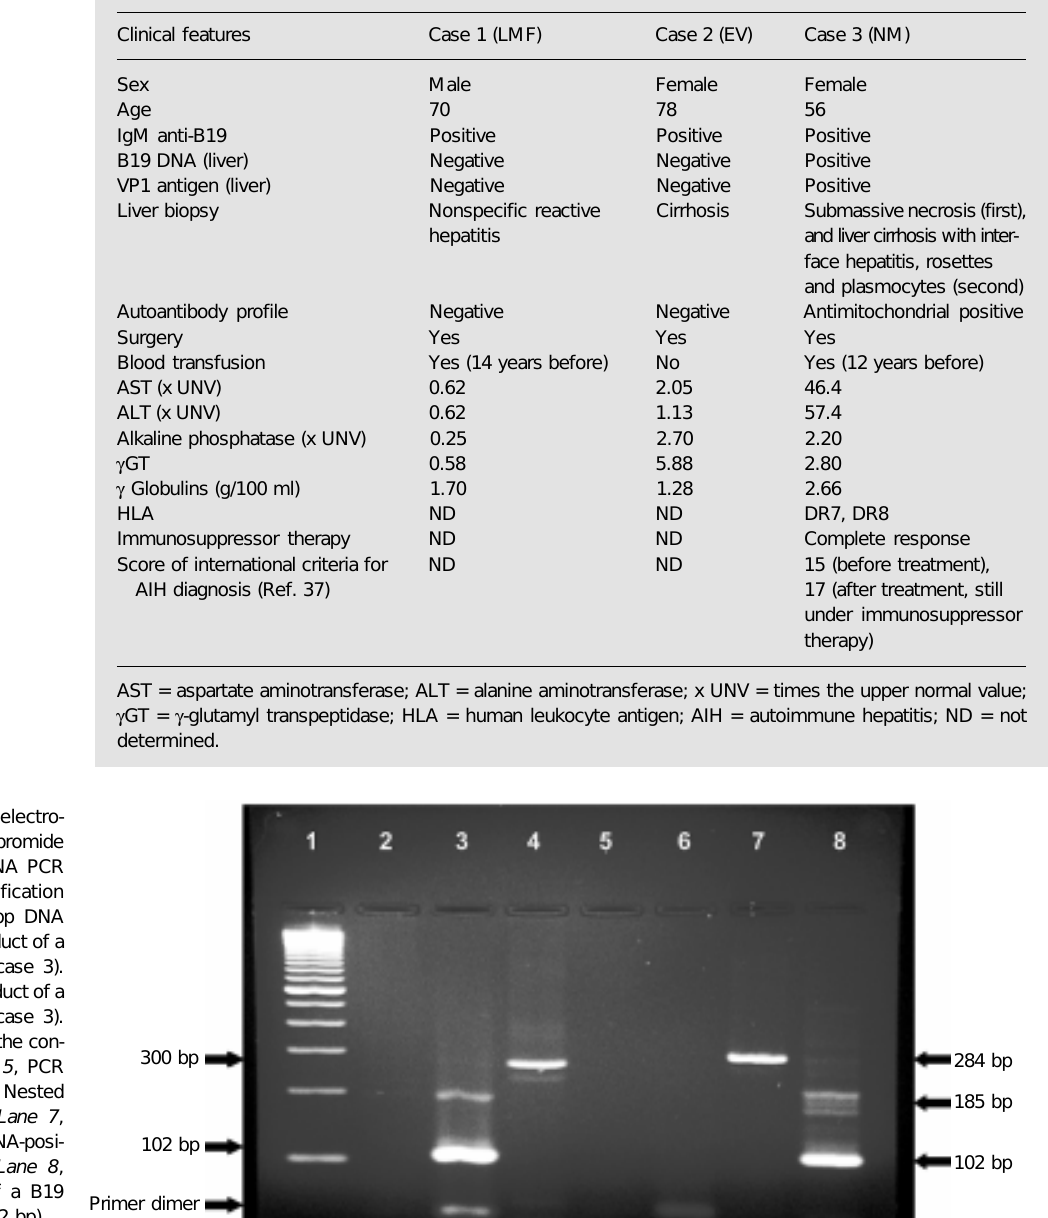
Table 1. Clinical features of three patients positive for parvovirus B19 IgM and